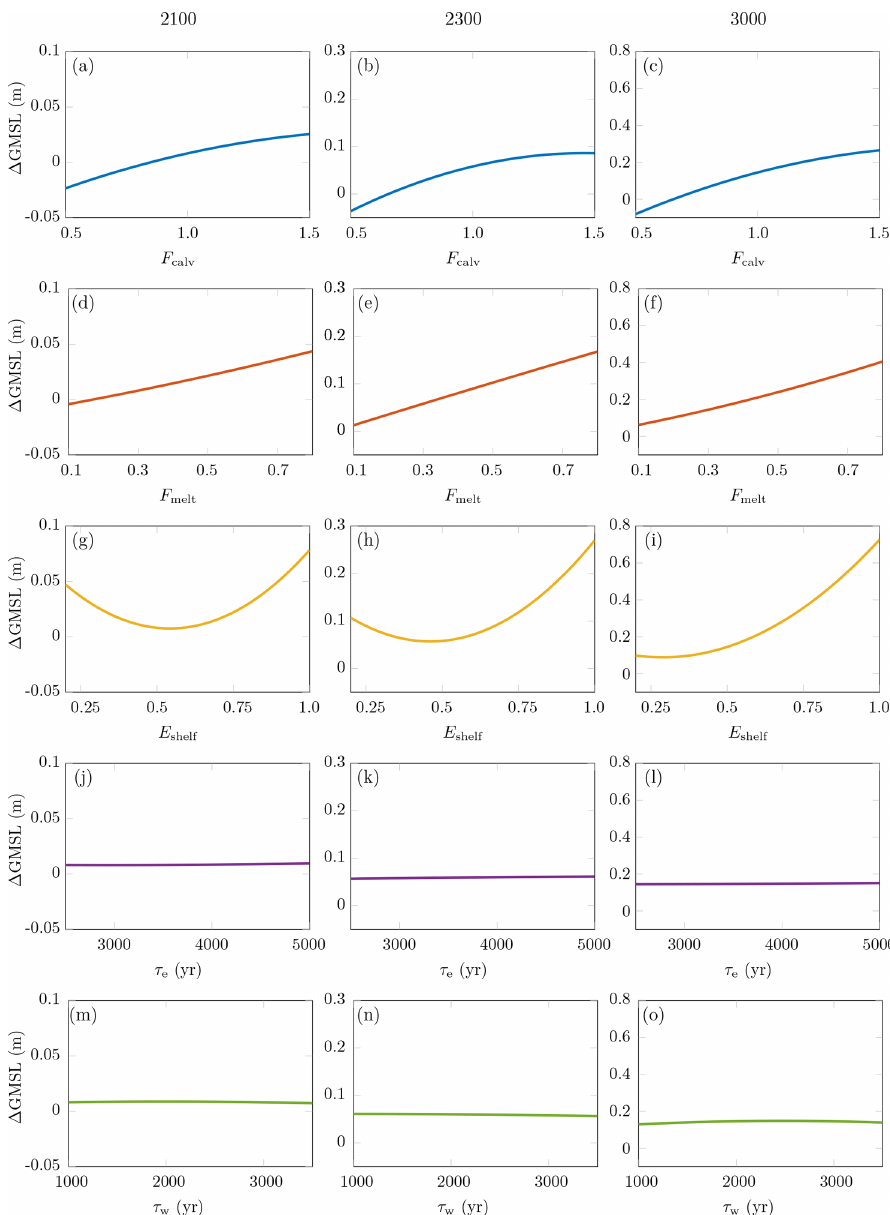
Figure 4. Representation of the parameters-to-projection relationships in RCP 2.6 under the weakly non-linear sliding law as given by a PC expansion. The PC expansion is shown for each parameter individually, with the other parameters fixed at their nominal value. PC expansions at (a, d, g, j, m) 2100, (b, e, h, k, n) 2300 and (c, f, i, l, o)